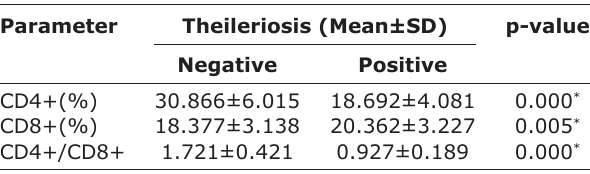
Table-2: Immunohistochemistry of CD4+, CD8+, and CD4+/CD8+lymphocytes ratio from blood samples of Bali